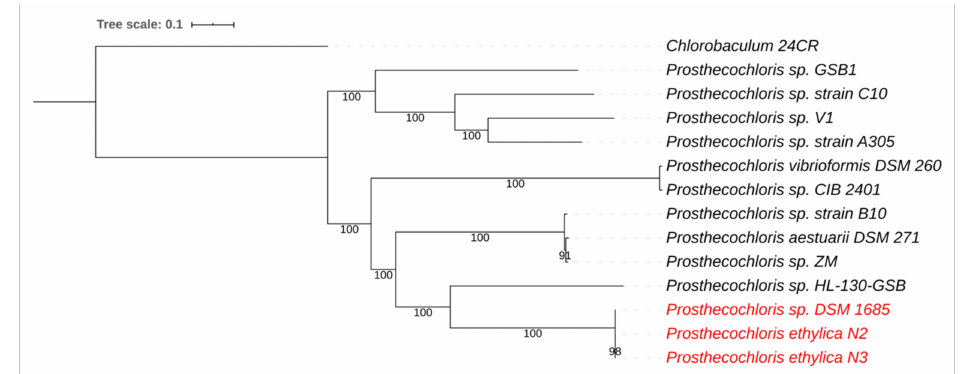
Figure 2. Whole-genome-based phylogenetic tree of all sequenced Prosthecochloris species. The phylogenetic tree was generated using the CodonTree method within PATRIC [22], which used PGFams as homology groups. The support values for the phylogenetic tree are generated using 100 rounds of the “Rapid bootstrapping” option of RaxML [25]. Chlorobaculum sp. 24CR was used as an outgroup [29]. The branch length tree scale is defined as the mean number of substitutions per site, which is an average across both nucleotide and amino acid changes. Species marked in red belong to the newly proposed Prosthecochloris ethylica comb.